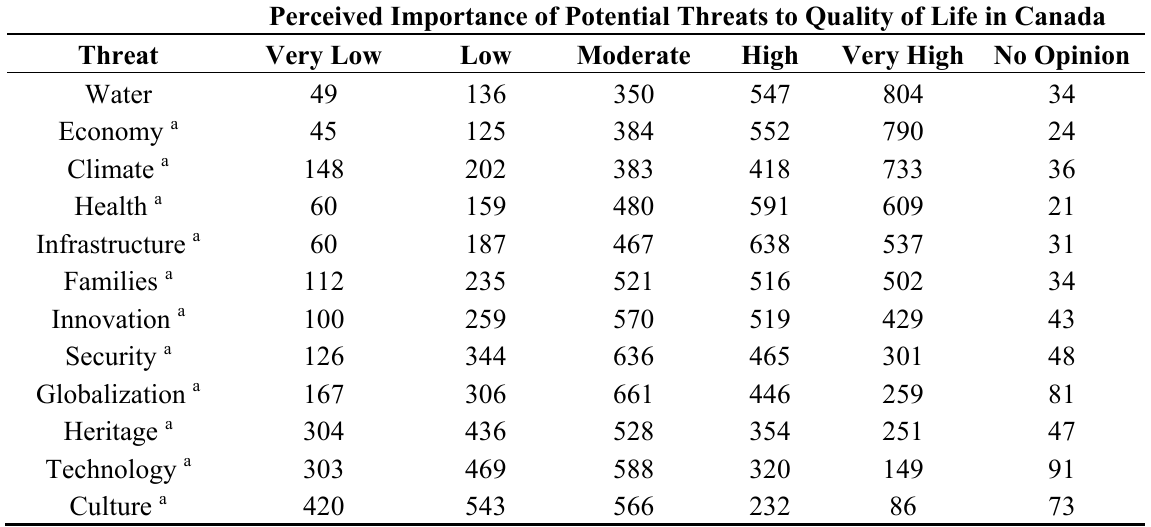
Table 3. Perceived importance of potential threats to Canadian quality of